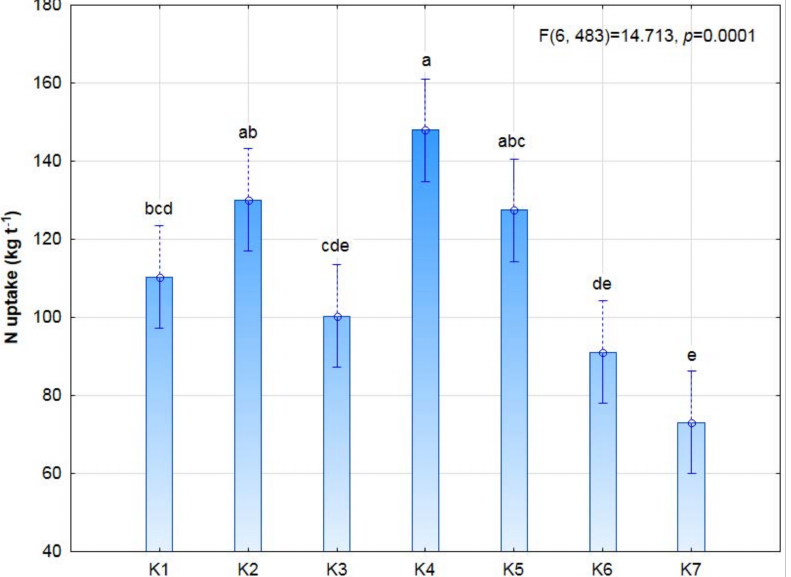
Figure 6. Nitrogen uptake with soybean yield, depending on photostimulation treatment. Different letters indicate significant differences between means. Significant effects at p < 0.05.